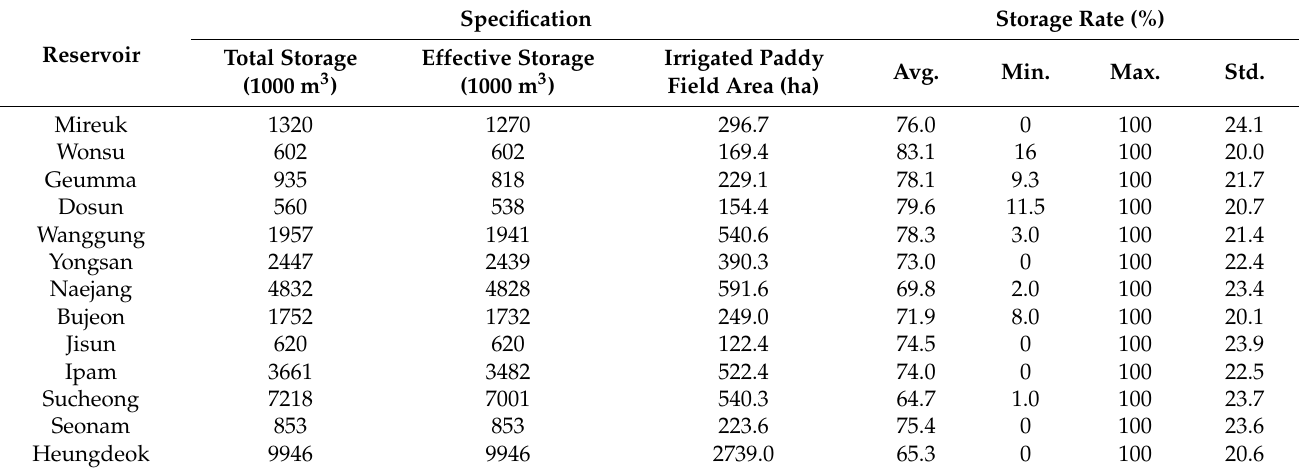
Figure 2. Variations in the average daily reservoir storage rates from January 1991 to March 2022.